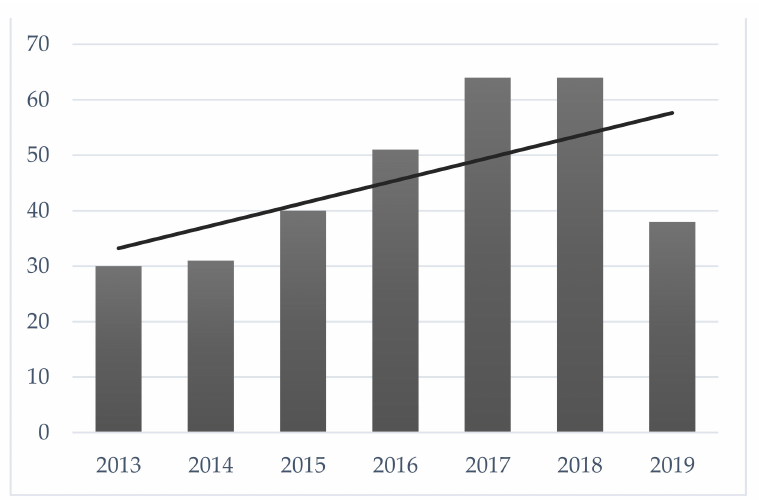
Figure 1. Distribution of the number of hospitalizations (January 2013–May